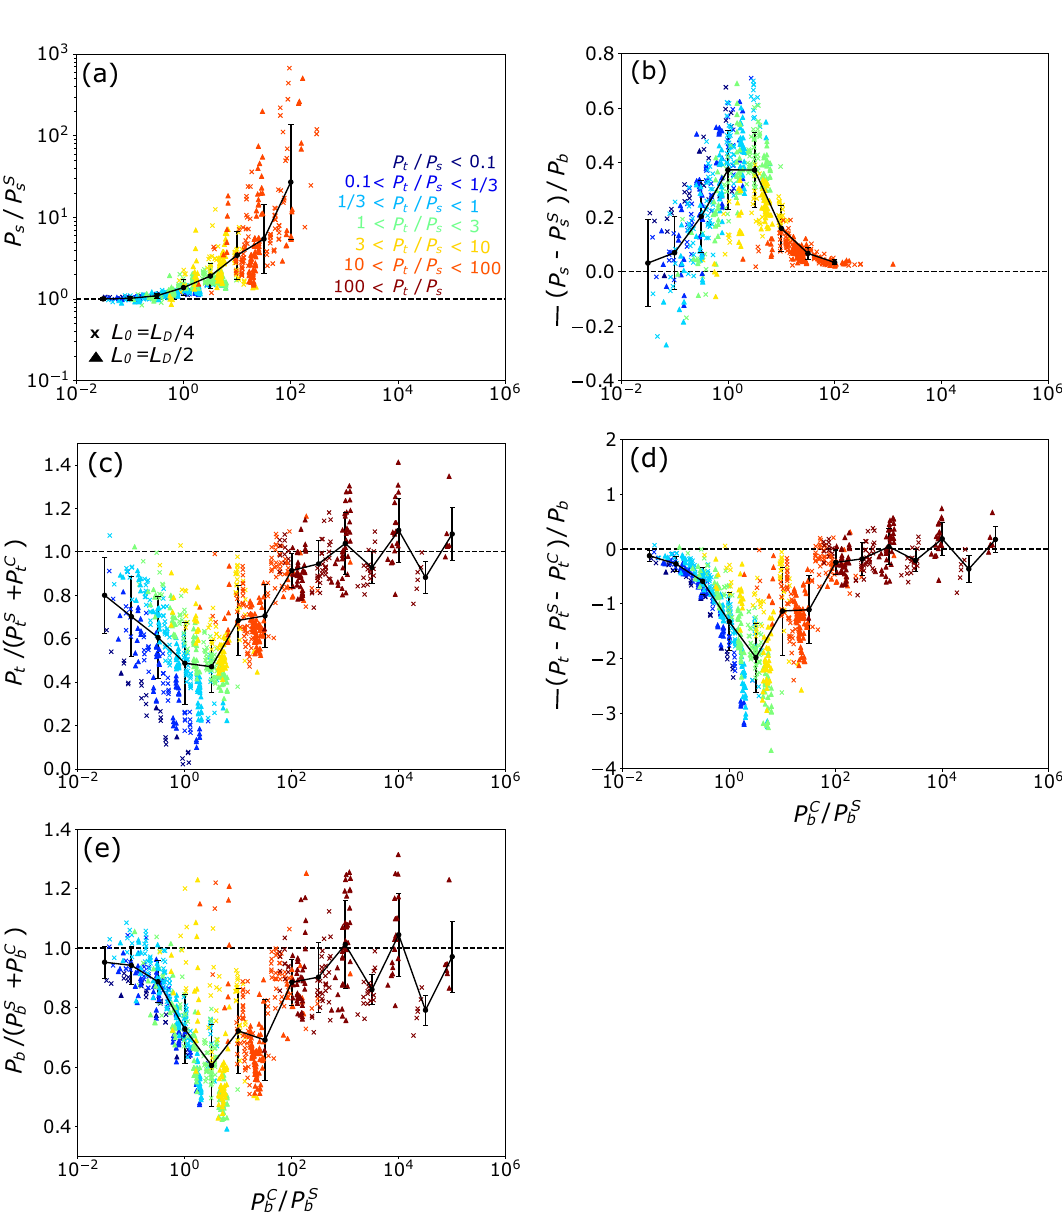
)/ P b , (c) P C P S s − / P S ) in the coexisting ST and CT simulations. P b /( P S P C b b and b + b